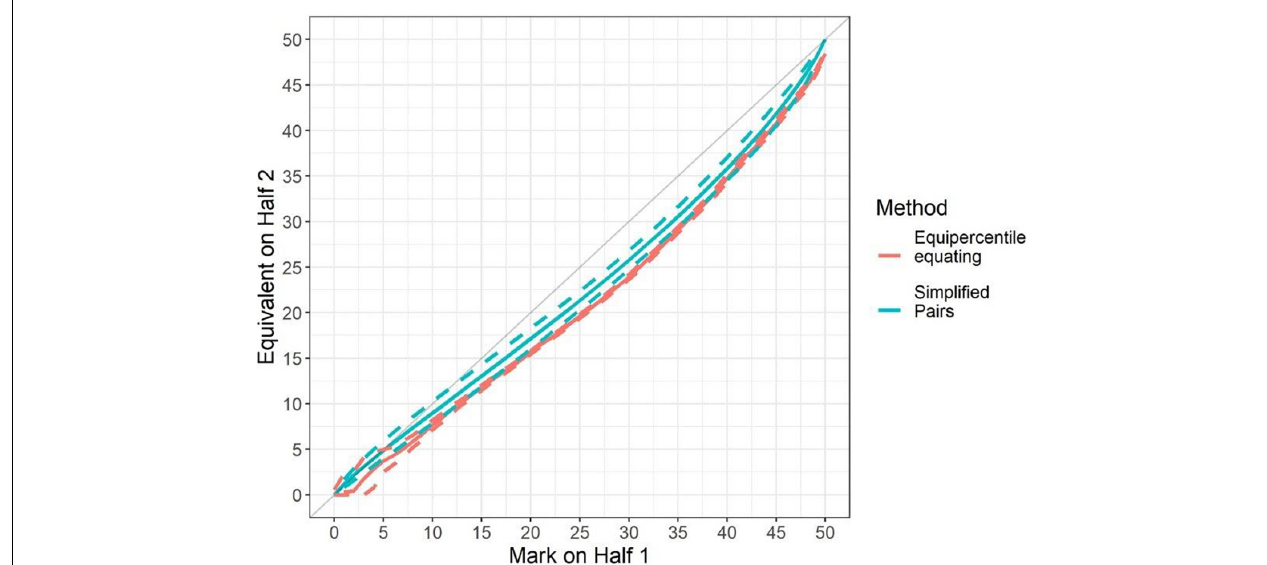
FIGURE 6 | Results of both equating and simplified pairs across the score range (mathematics).